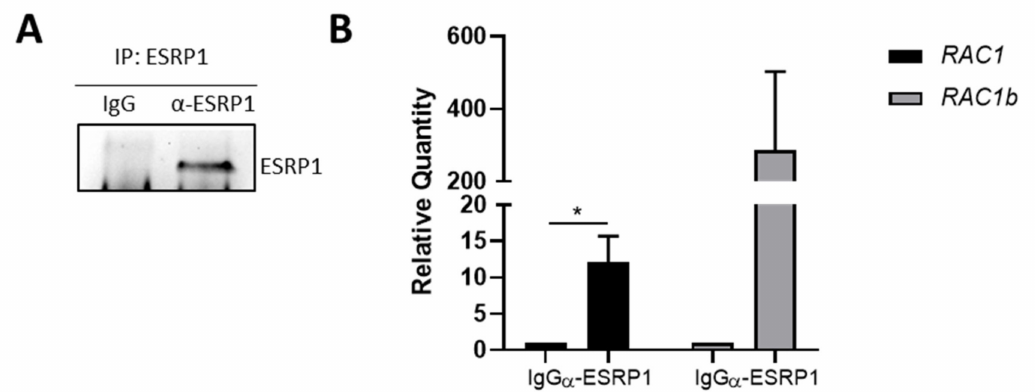
Figure 5. RNA-immunoprecipitation (RNA-IP) in ERSP1-overexpressing COLO320DM CRC cells. ( A ) Western blot analysis of ESRP1 immunoprecipitation. Rabbit IgG was used as negative control. ( B ) qRT-PCR analysis of ESRP1- and IgG-bound transcripts. Gene expression levels of RAC1 and RAC1b in three independent experiments of RNA-IP. Data are expressed as mean ± SEM of quantification relative to IgG negative control. Unpaired t-test was performed: * p < 0.05.